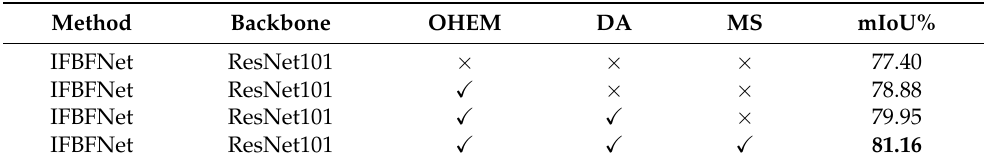
Table 4. Performance comparison between different strategies on the Cityscape validation set. OHEM stands for online hard example mining loss function. DA represents data augmentation with random scaling. MS represents multi-scale inputs during inference.The blackened numbers represent the best performing group in this set of data.